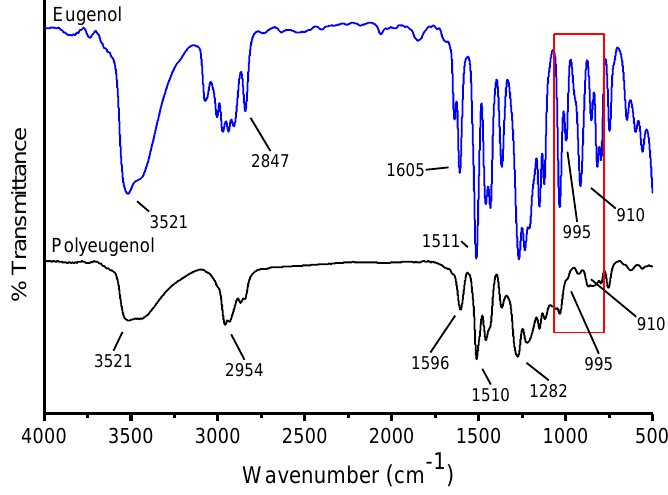
Figure 2. FTIR Graph of eugenol and polyeugenol.